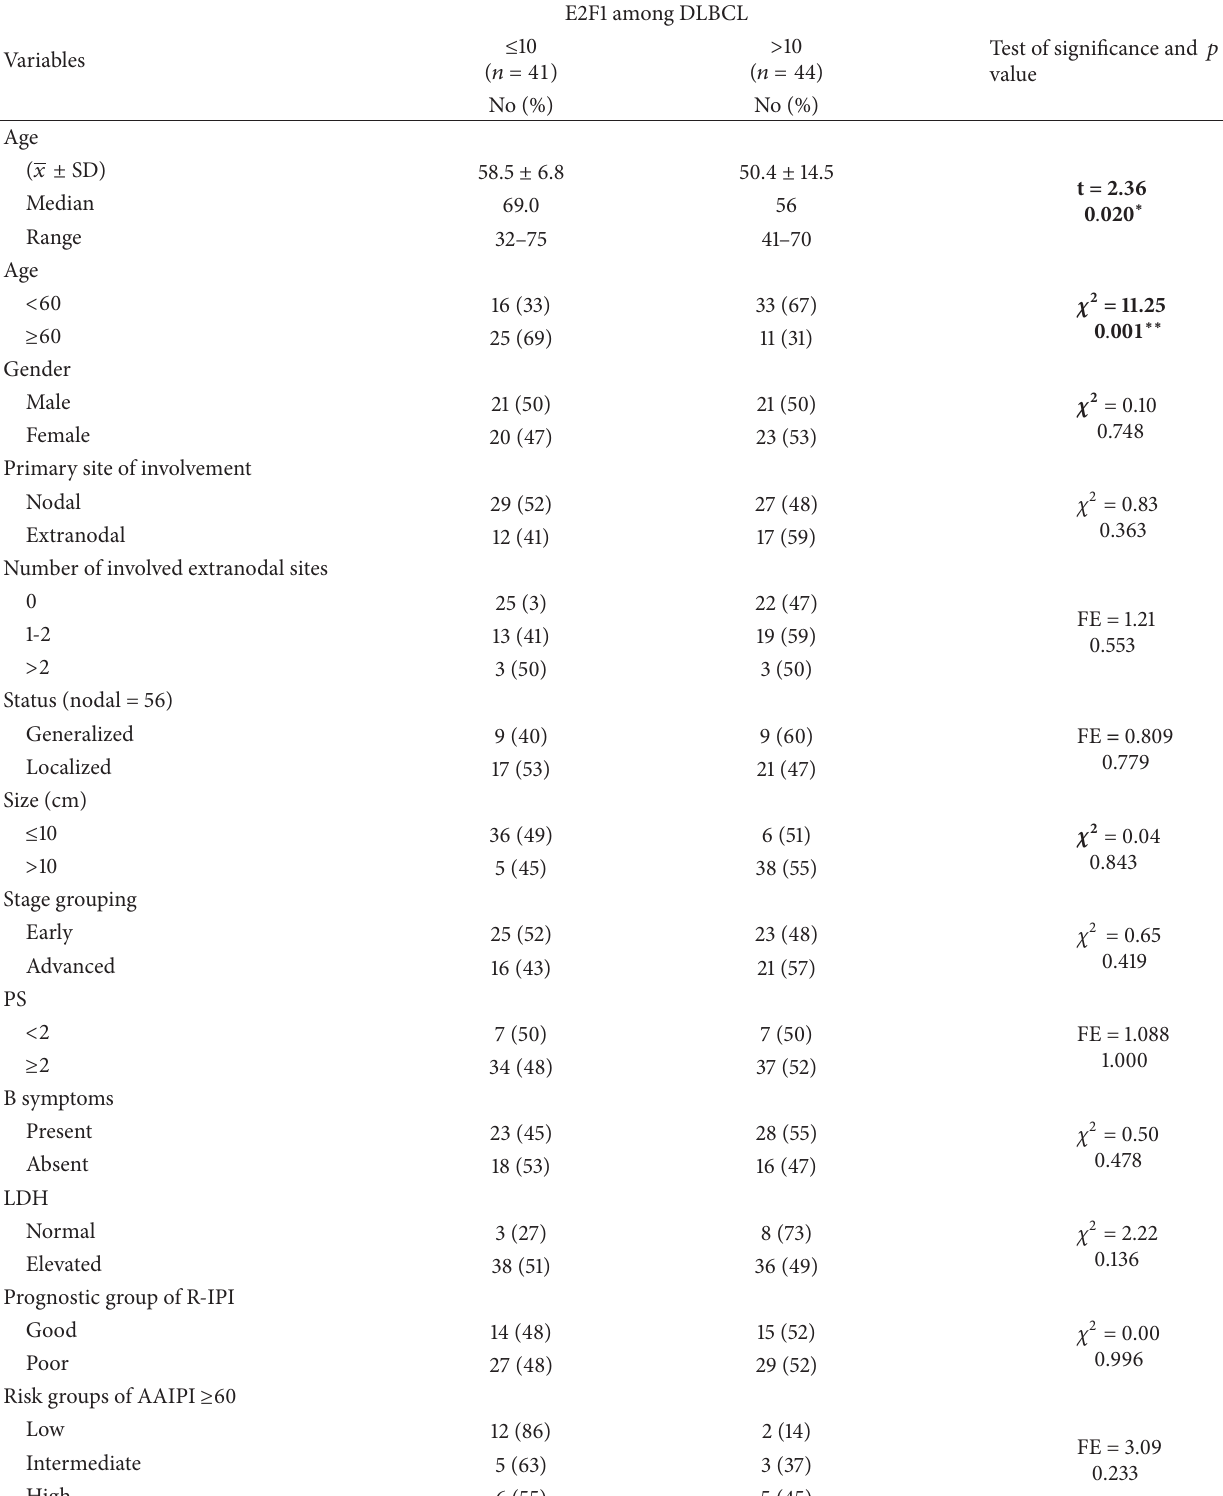
Table 3: Relationship of E2F1 expression with the clinicopathological data and expression of SV40 in DLBCL cases.